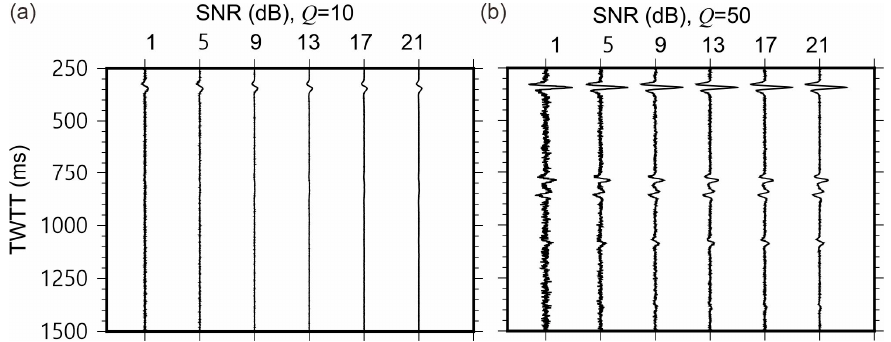
Figure 2. Seismograms with ( a ) Q = 10, ( b ) Q = 50 in Figure 1a with added Gaussian random noise. Trace labels show the signal-to-noise ratios (SNR) in the records.